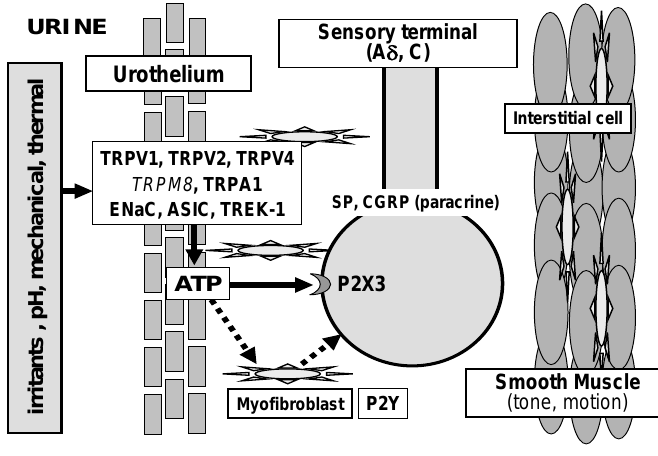
Figure 3. Possible roles of nociceptive ion channels in indirect activation of sensory nerve by mediators released from urothelial cells. Italic letter indicates ion channels with weak evidence for functional